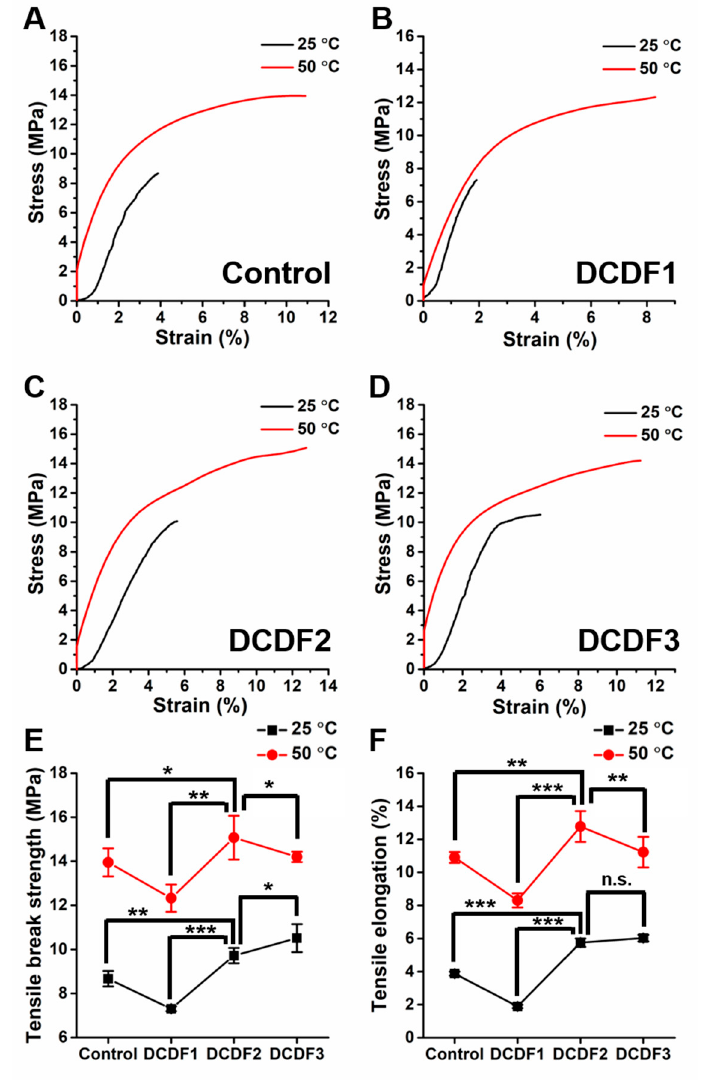
Figure 5. Tensile properties of DCDFs and the control group evaluated by DMA and a tensile tester under 25 °C or 50 °C. ( A – D ) Tensile stress-strain curves of ( A ) the control group, ( B ) DCDF1, ( C ) DCDF2, and ( D ) DCDF3. Changes of ( E ) tensile break strength and ( F ) tensile elongation of all films. * p < 0.05, ** p < 0.01, and *** p < 0.001 between the indicated groups.